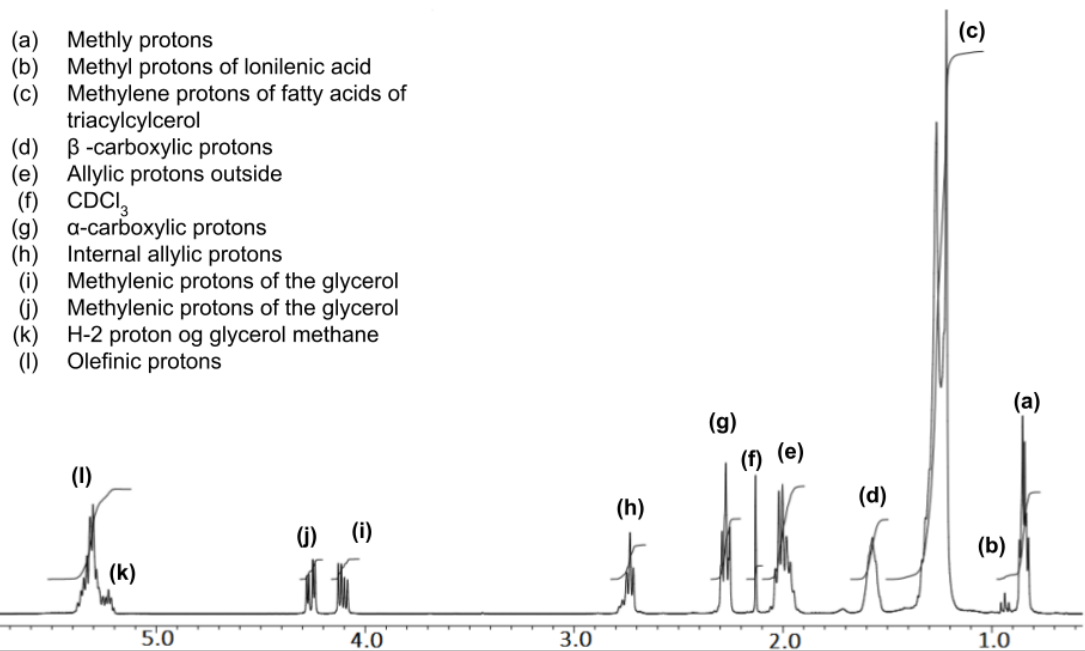
Figure 16. 1 H-NMR spectrum of waste cooking oil(WCO) in CDCl 3 .